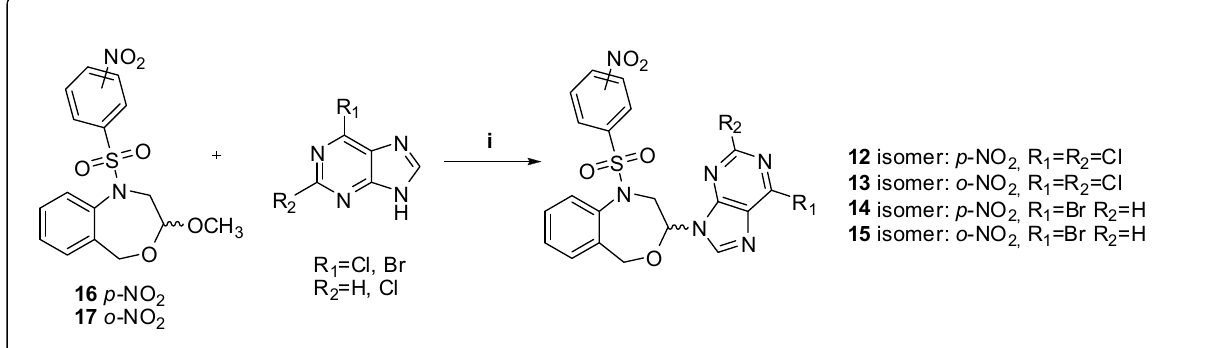
Figure 5. Preparation of the O,N -acetals anticancer derivatives 12 – 15